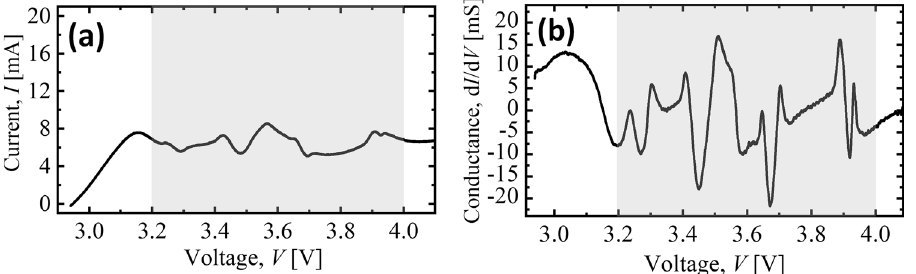
Figure 3. ( a ) Current, I –Voltage, V characteristics derived from cyclic voltammetry experiment of the K cation extraction (charging) process with K 2 Ni 2 TeO 6 as the cathode in a two-electrode setup. K metal was used as the 1 80 counter electrode and the scanning rate was set to 0.1 mVs − . The current peaks at varied spread-out voltage values reflective of the small activation energy of K cations in the honeycomb layered oxide material. ( b ) The w σ of K 2 Ni 2 TeO 6 during the charging process displaying conductance spikes at varied conductance, dI / dV ∼ spread-out voltage values corresponding to extractions of a large number of K cations from multiple honeycomb N 1 and σ cannot be separately determined from the k w , where the values of w lattice layers, k ∈ ≫ → + results. Nonetheless, the sharp conductance spikes occur evenly distributed at a rough interval of 0.1 V within the voltage interval, 3.2 V to 4.0 V (gray/shaded